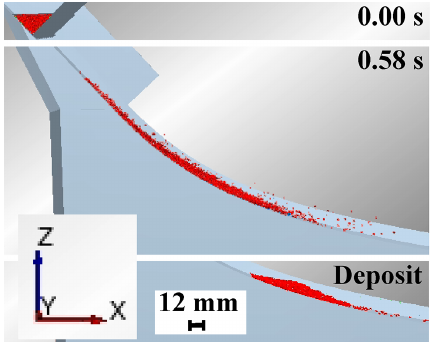
Figure 5. Cross sections illustrating three moments of a flow his- tory. The frame at the top shows the granular material at rest behind the gate before release. The frame in the middle shows the fully de- veloped shape of travel of the granular flow. The lower frame shows the final deposit. In this example the granular mass is 93g, the grain size is 2mm, w is 26mm and θ is 27 ◦ . The values measured in seconds show the time elapsed since the gate removal.